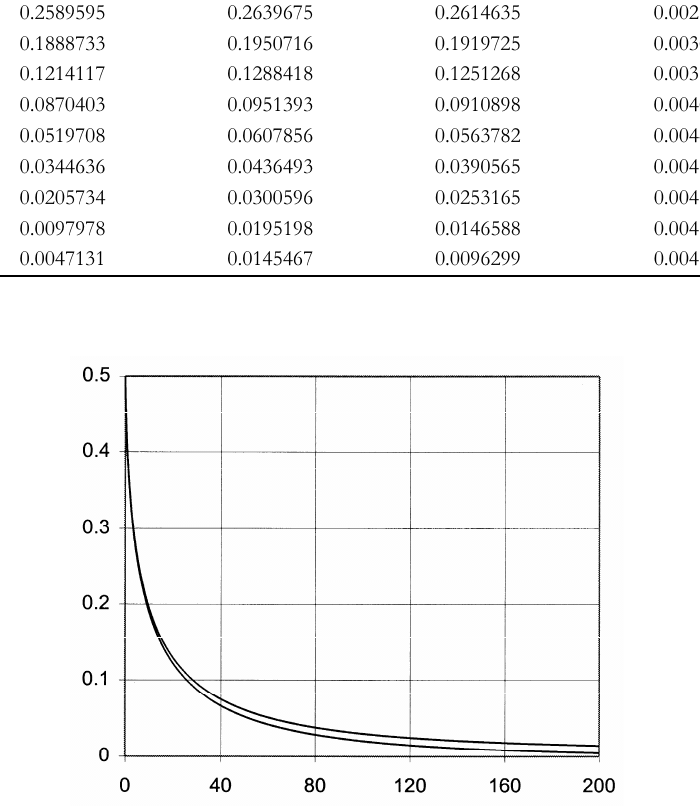
Figure 2 – Lognormal, with mean 1, variance 25.53372 and (cid:84) =1, using (cid:39) =0.01.